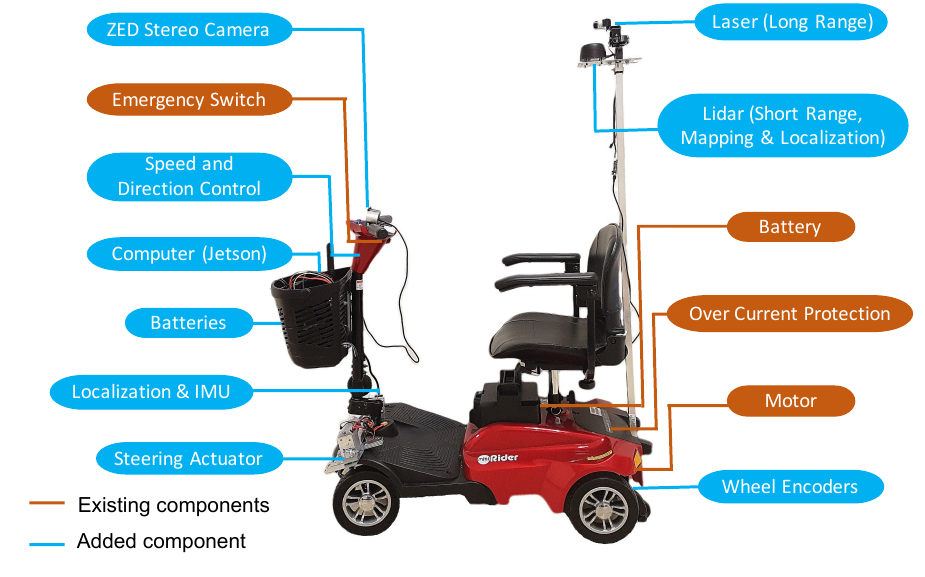
Figure 1. The autonomous scooter design.